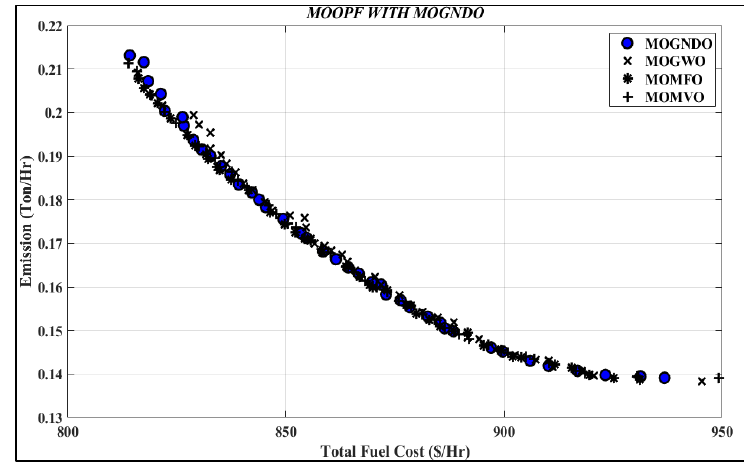
Figure 20. PF of TFC and emission minimization.